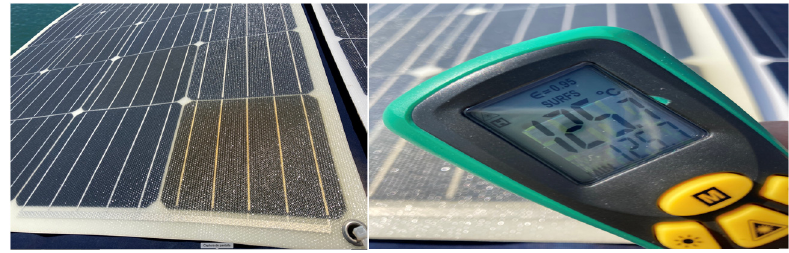
Figure 19. Brownish effect and temperature on a cell after a day of its installation.